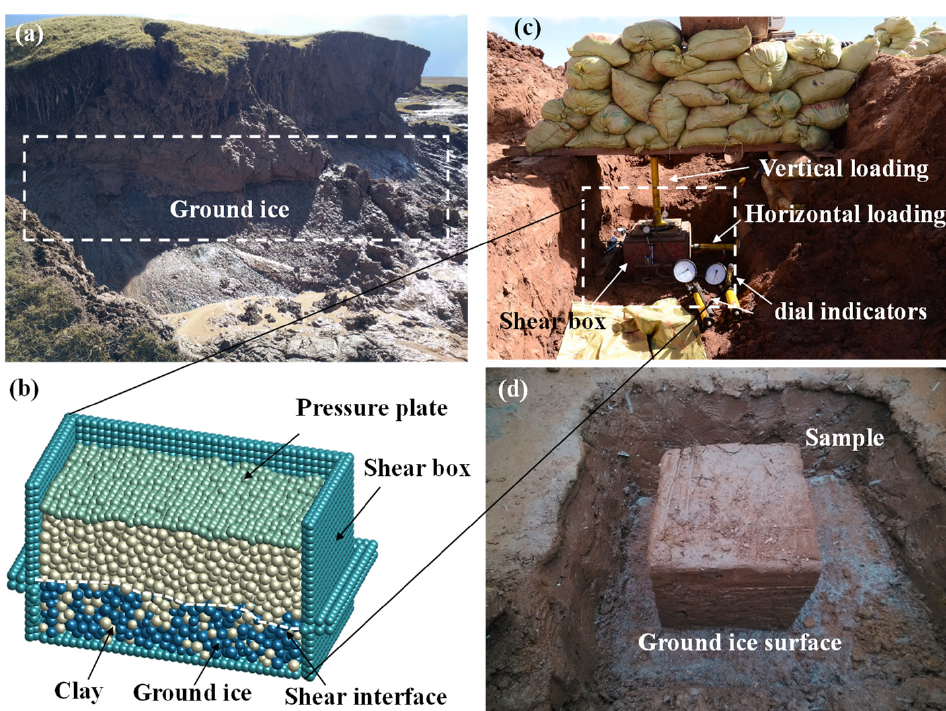
Figure 5. Diagrams of numerical and in situ shear strength tests. ( a ) The active layer and ground ice interface; ( b ) a cross-section of the discrete element model; ( c ) in situ shear strength test setup [9]; ( d ) a cutting soil sample on the surface of the massive ground ice [9]. Table 1. Geotechnical properties at the K1129W thaw slump site.